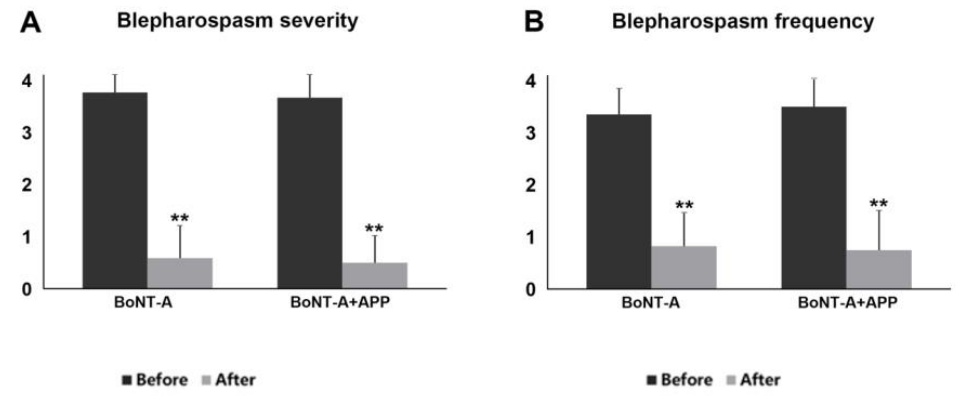
Figure 2. The ( A ) severity and ( B ) frequency of blepharospasm in the BoNT-A group and the BoNT-A+APP group before and after treatment (** p < 0.01).